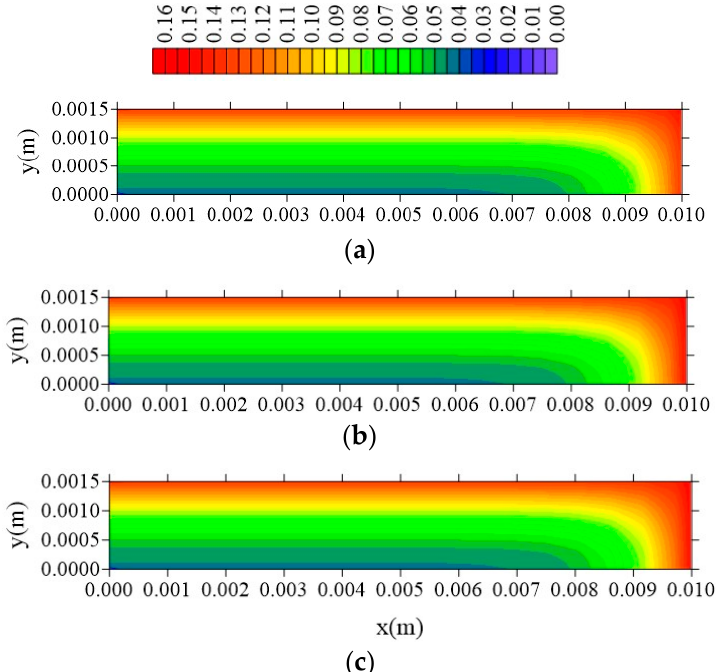
Figure 16. Distribution of free solute concentration (C in kg/kg) in plan z = R z /2 for different distances l x (t = 211 h, Cases 8, 9, and 10). In which ( a ) l x = 0.01 m; l y = 0.01 m and l z = 0.1 m; ( b ) l x = 0.1 m; l y = 0.01 m and l z = 0.1 m; ( c ) l x = 1 m; l y = 0.01 m and l z = 0.1 m.